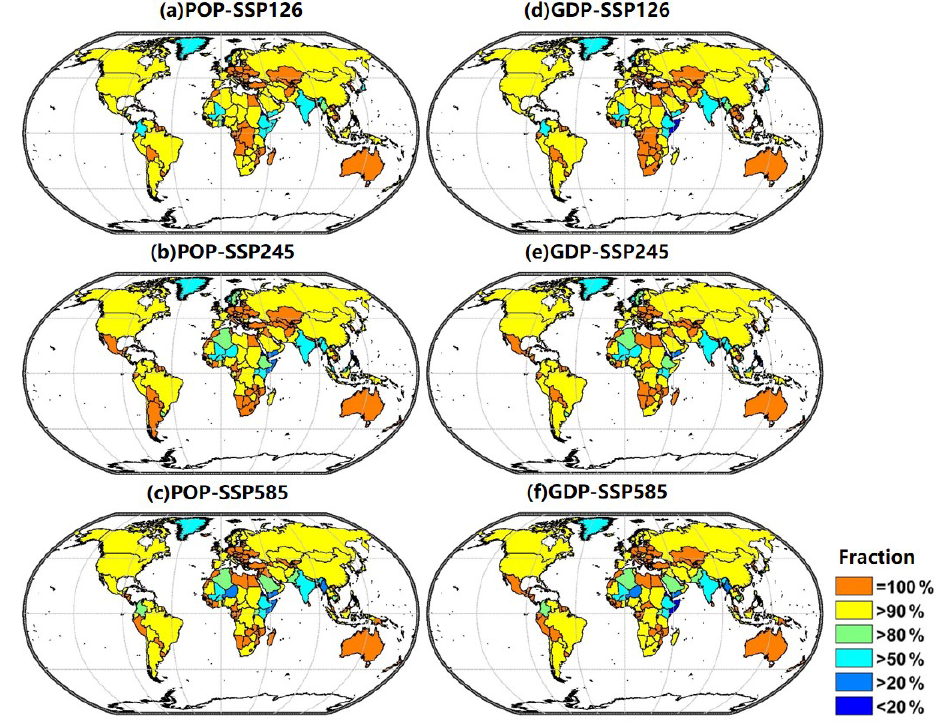
Figure 10. National population and GDP fraction exposure to more frequent severe droughts under the 2.0 ◦ C warming